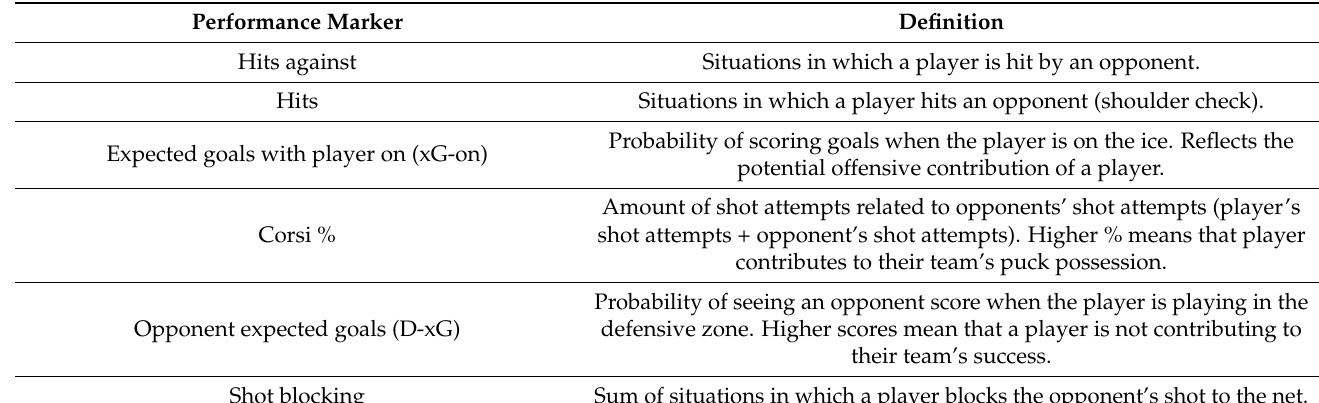
Table 1. Match performance indicators, collected with the InStat ®